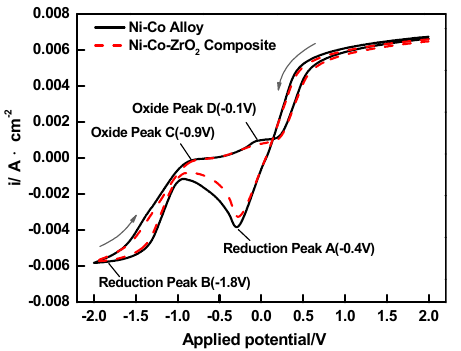
Figure 1. Cyclic voltammetry (CV) curves on pure copper in electrolyte with and without nano-ZrO 2 particles, scan rate 100 mV/s, ultrasonic power 100 W, T = 40 °C, and pH = 4.